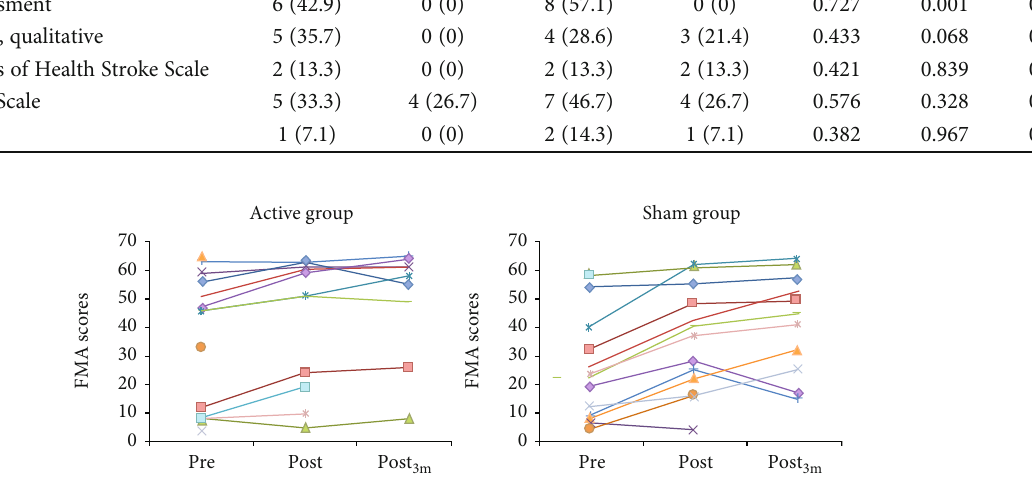
Figure 2: Absolute values of the Fugl-Meyer Assessment (FMA) of motor recovery after stroke scores at speci fi c time points, for each participant in the active and sham